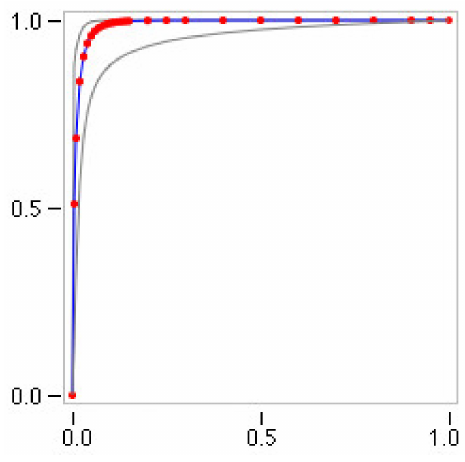
Figure 2. The ROC area of the validation data: AUC